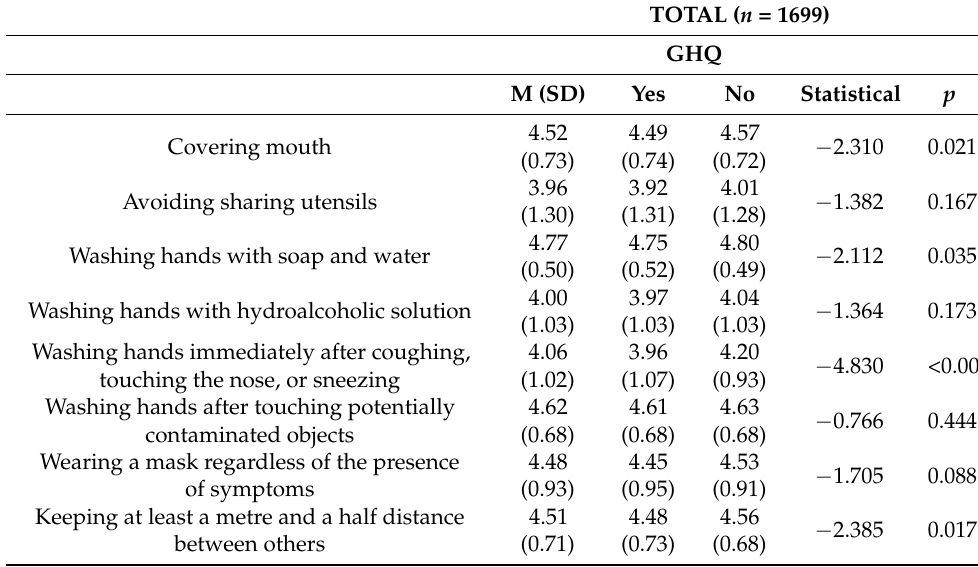
Table 5. Contrast between preventive measures and psychological distress during the